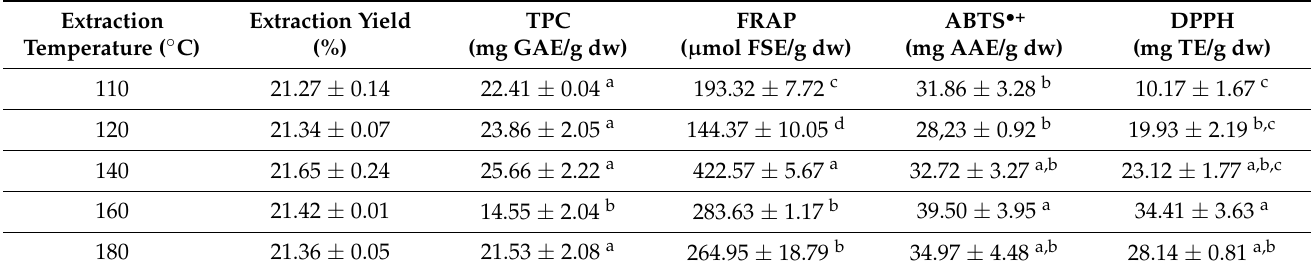
Table 1. Extraction yield, total phenolic content (TPC) and in vitro antioxidant/antiradical activities (evaluated by FRAP, ABTS • + and DPPH assays) of S. ramosissima extracts obtained by SWE. Values are expressed as mean ± standard deviation ( n = 3). Different letters in the same column indicate significant differences ( p <